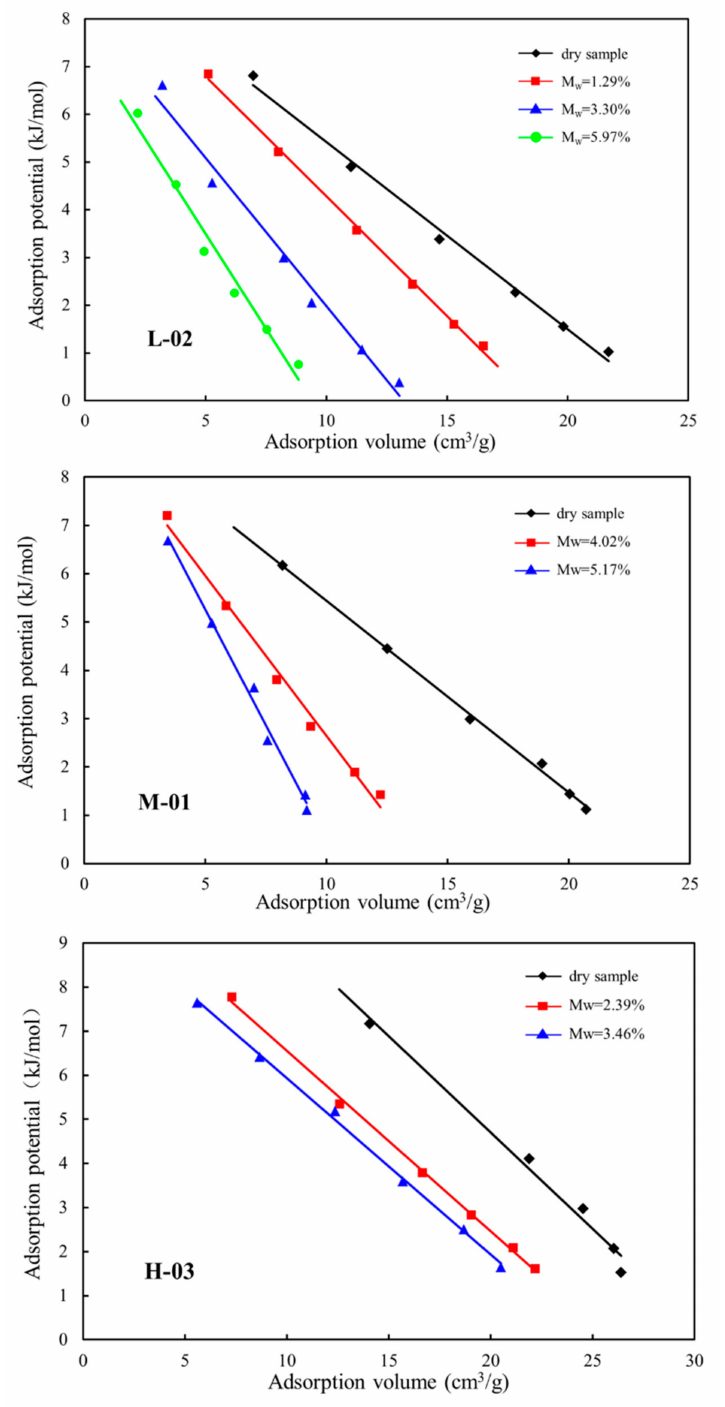
Figure 6. Relationship between the adsorption capacity and adsorption potential of samples with di ff erent moisture